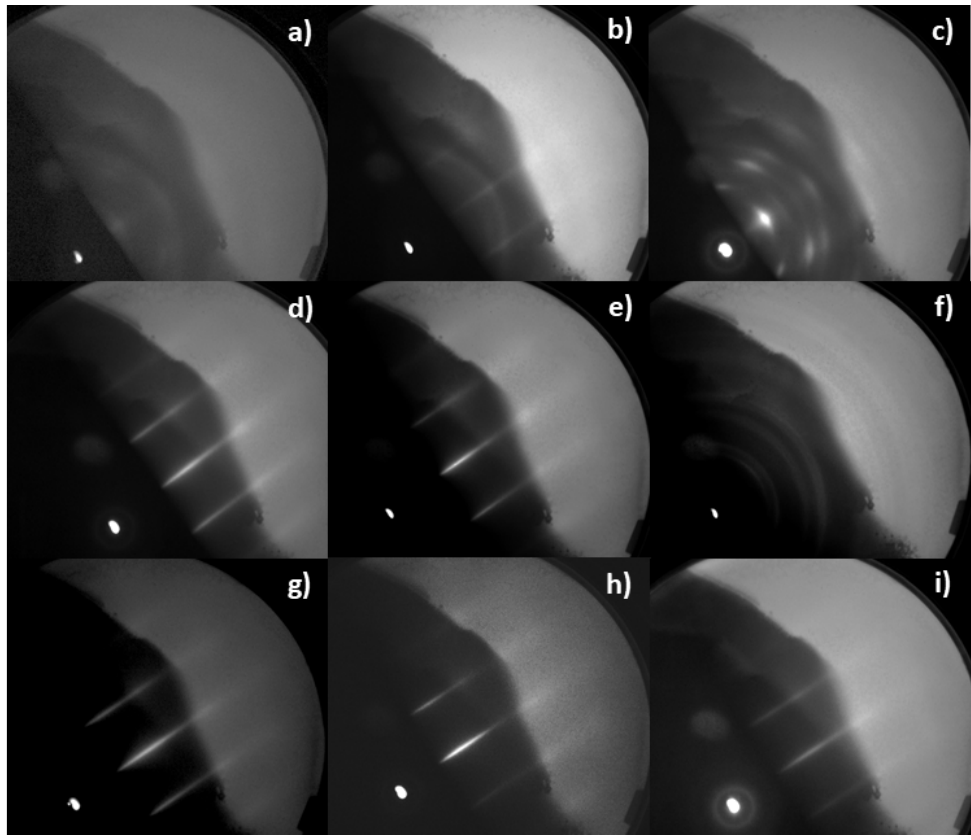
Figure 3. RHEED images of ( a ) 80 °C, ( b ) 210 °C, ( c ) 210 °C rotated 90°, ( d ) 240 °C, ( e ) 255 °C, ( f ) samples after 30 min annealing at 255 °C, ( g ) 270 °C, ( h ) 330 °C and ( i ) 400 °C films grown on AlN (0001) samples.